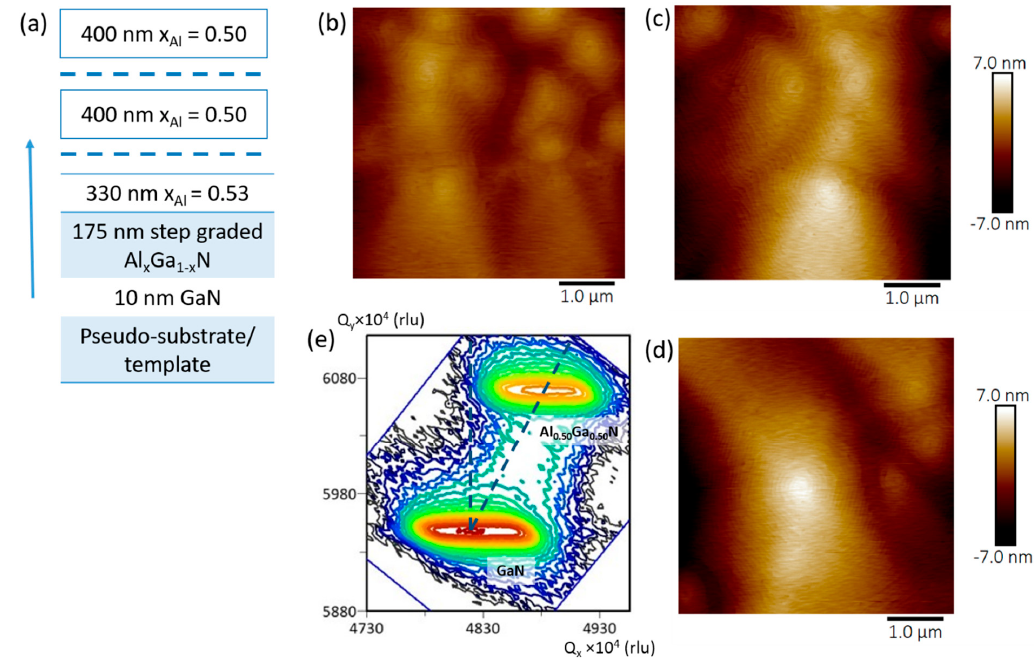
Figure 4. ( a ) Schematic of the second structure grown on porous GaN. The x Al is obtained from RSM, and the dashed lines indicate regrowth interfaces. 5 × 5 µm 2 AFM height images of ( b ) initial ~500 nm AlGaN; ( c ) after first regrowth (corresponding to d total ~900 nm AlGaN); ( d ) after second regrowth (d total ~1.3 µm AlGaN) showing good surface morphology. ( e ) RSM obtained from XRD with the GaN and 1.3 µm AlGaN peaks marked shows that Al 0.50 Ga 0.50 N is fully relaxed. The vertical dashed line running up each scan from the GaN peak shows the strain line while the other dashed line is the fully relaxed line.